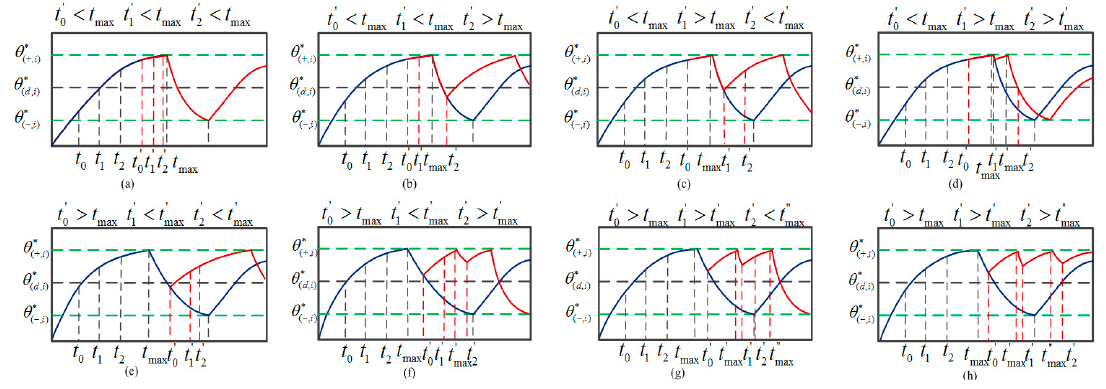
Figure 4. ( a ) Response delay only; ( b – h ) response delay with extra power consumption.